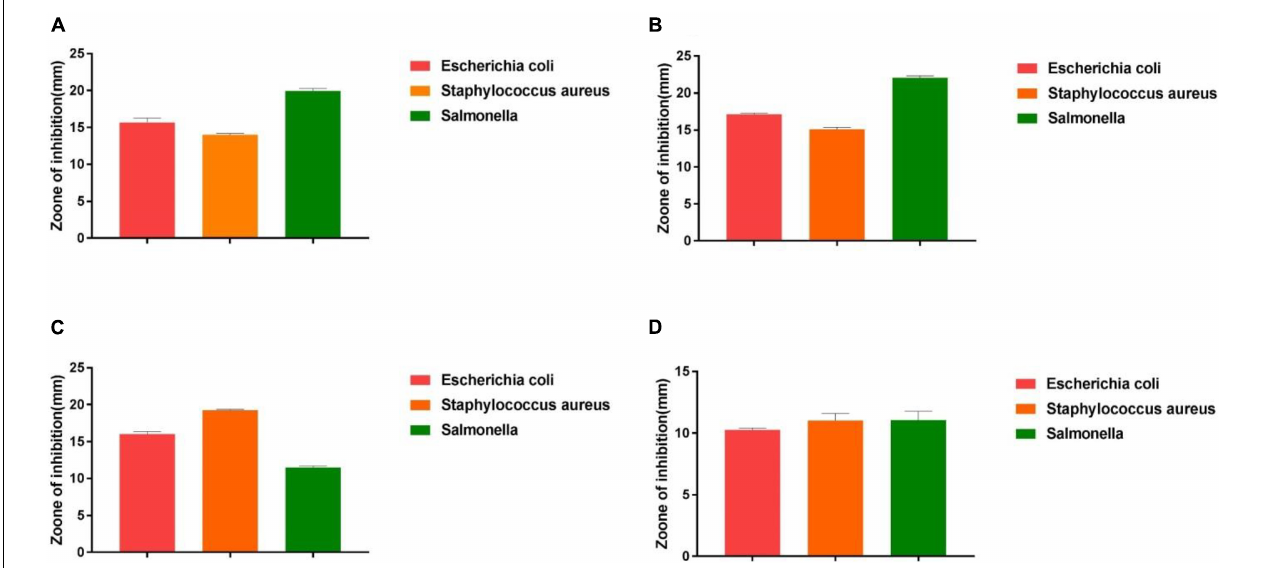
FIGURE 4 | The results of the antibacterial experiment. (A) The result shows the antimicrobial capacity of Z1. (B) The result shows the antimicrobial capacity of Z2. (C) The result shows the antimicrobial capacity of J. (D) The result shows the antimicrobial capacity of K.